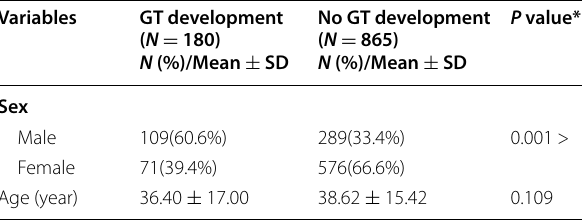
Table 2 Pre-operative demographic features of cases with GT in the first